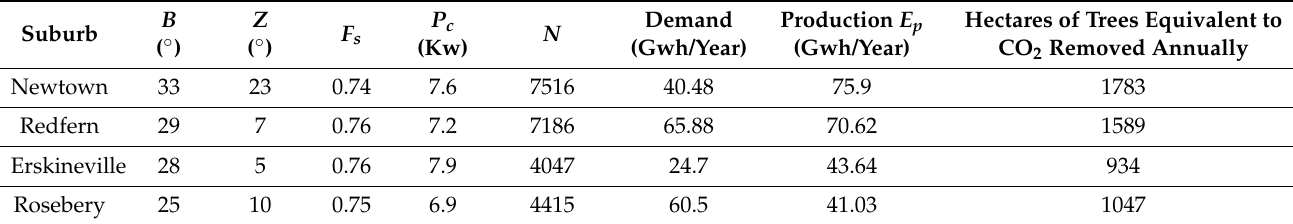
Table 2. Annual energy production of suburban rooftop PV systems ( E max = 1796 kWh/kW). All values of β , Z , F s , and P c are the average of the respective